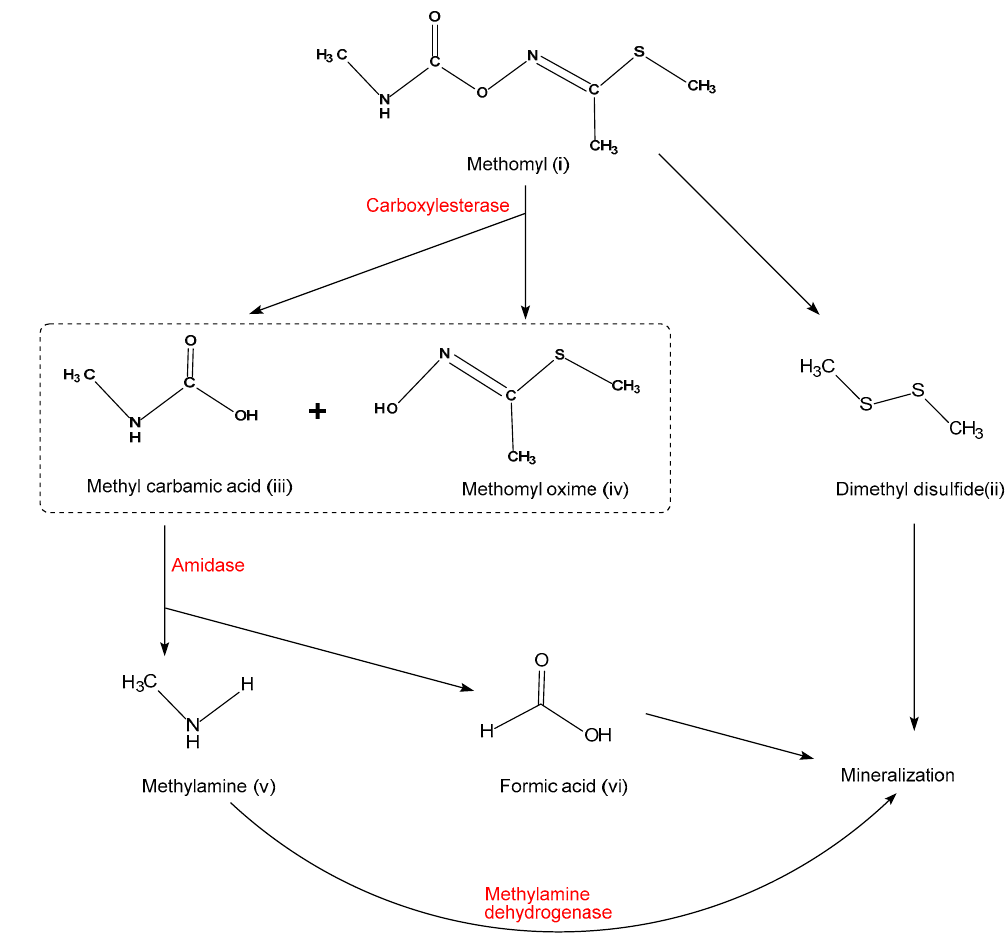
Figure 4. Proposed microbial degradation pathways of methomyl, adapted from [28,29,83].